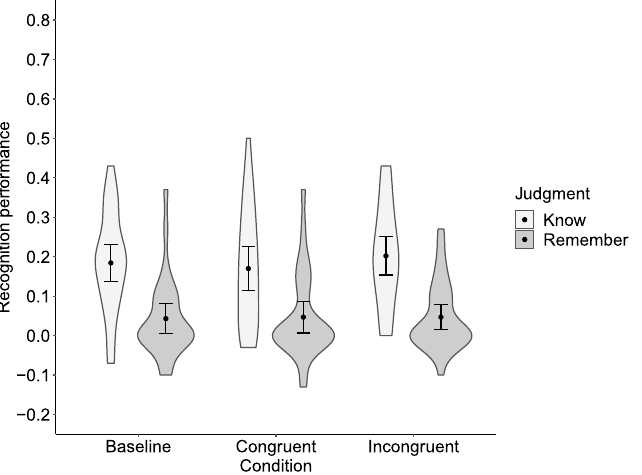
Figure 6. Remember- and Know-recognition performances in Experiment 2. Black dots depict means. Error bars depict 95% confidence intervals. Violin plots show the data